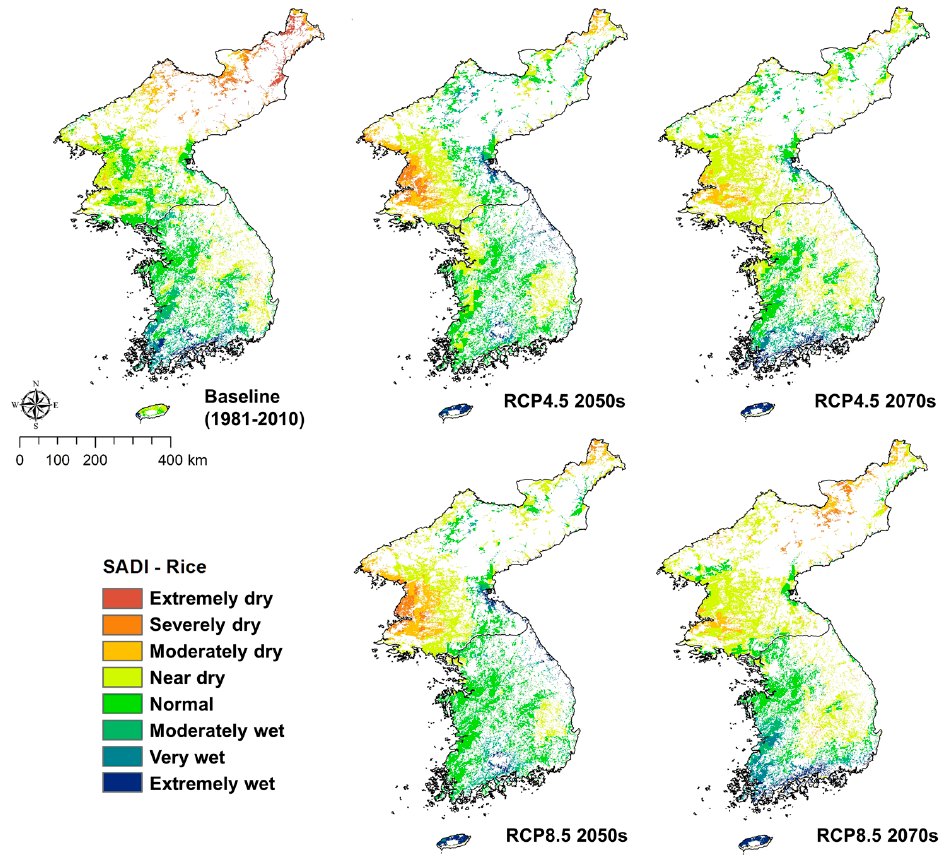
Figure 8. Spatial distribution of the Standardized Agricultural Drought Index for rice (SADI-Rice) in the baseline and future climate scenarios.